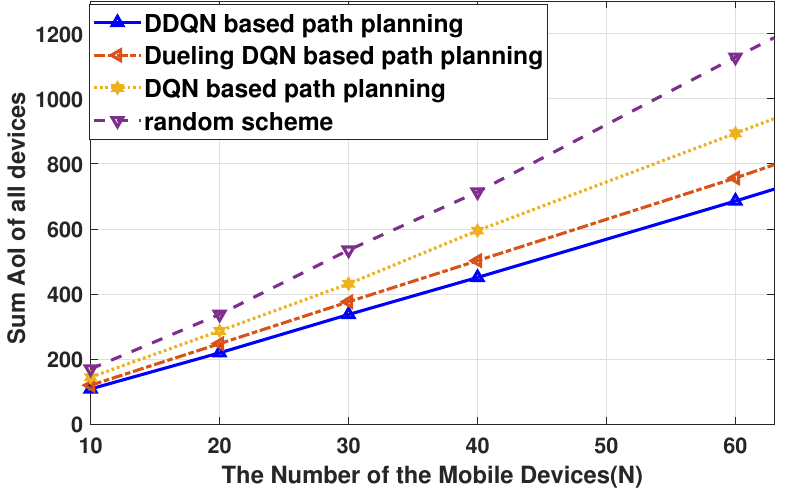
Figure 4. Achieved AoI of proposed path planning scheme with a different number of mobile devices, and v = 2 m/s, H = 15